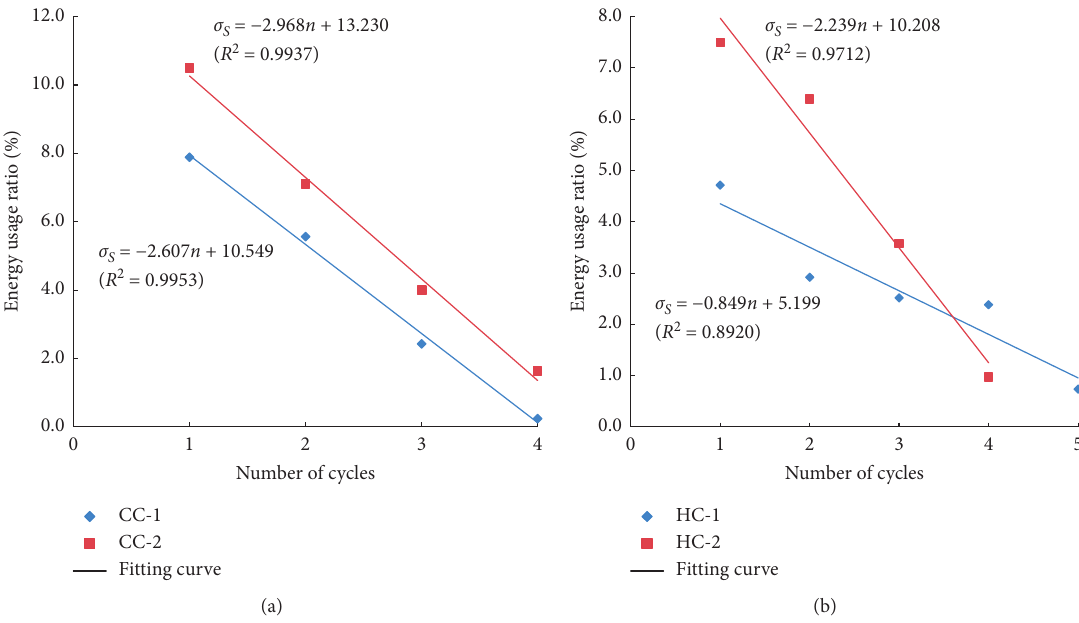
Figure 7: Relation between the energy utilization ratio and number of cyclic impacts. (a) Mortar. (b)